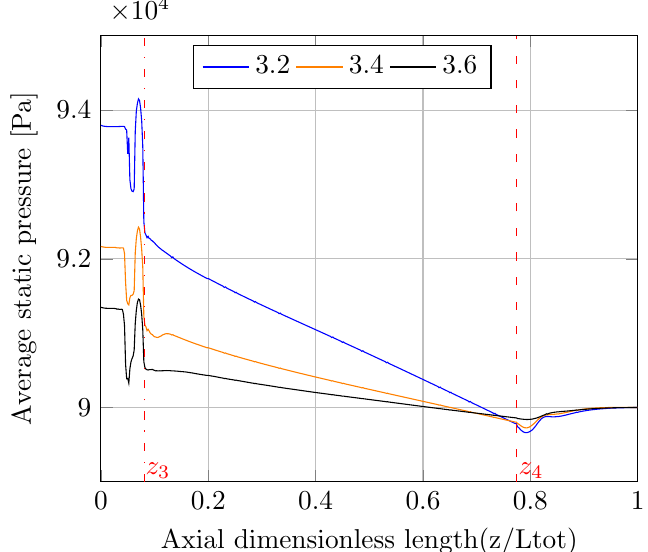
Figure 18. Average static pressure in the axial direction for different D values ( d = 0.77 mm, L = 32.2 mm, ∆ p = 90